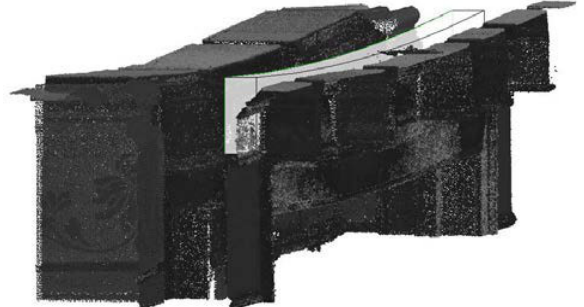
Fig.7 – Beam from the main hall modelled from pointcloud demonstrating structural